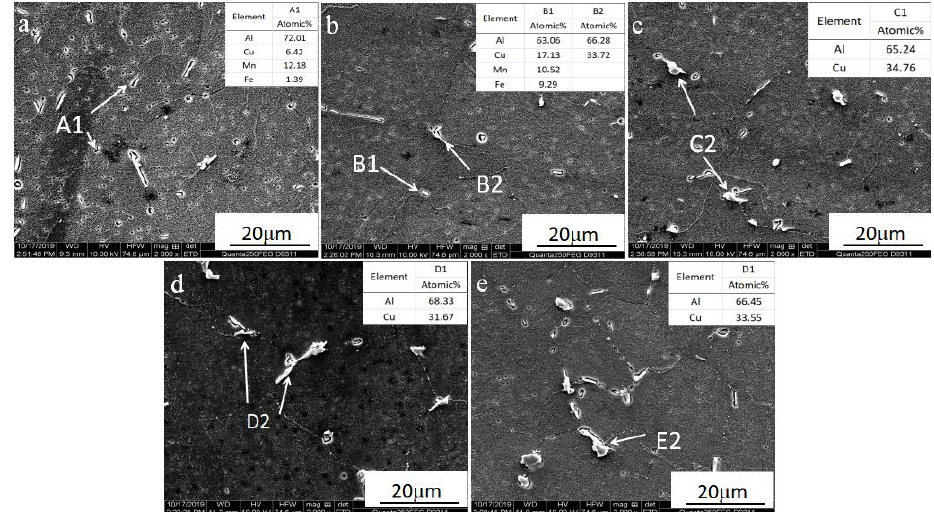
Figure 7. SEM and EDS of deposits with different heat inputs in T6 state. ( a ) 30 J/mm; ( b ) 60 J/mm; ( c ) 90 J/mm; ( d ) 120 J/mm; ( e ) 150 J/mm.